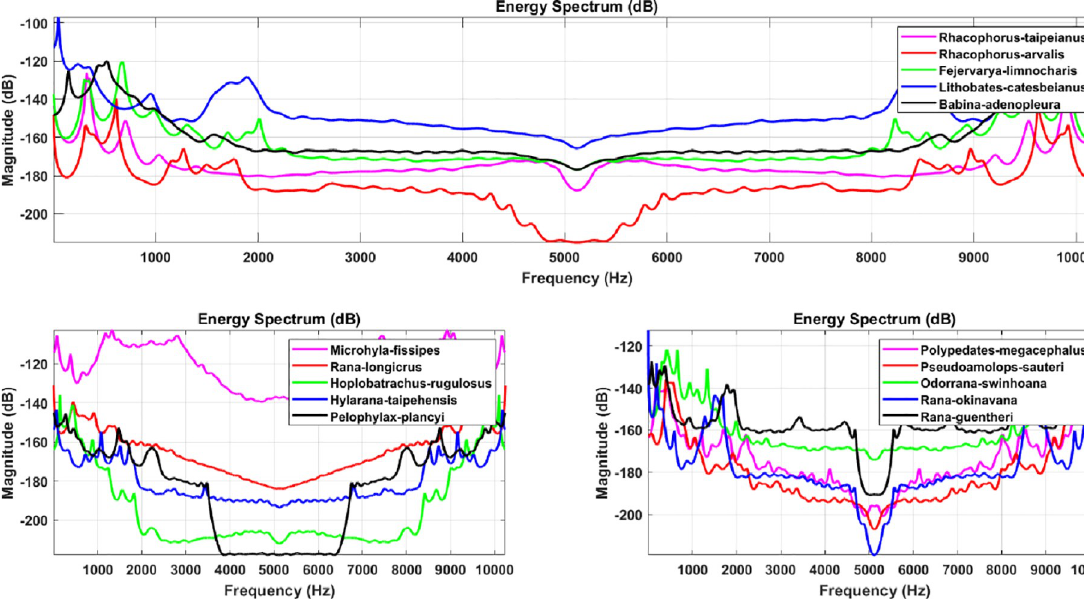
Fig 8. The spectrum diagram of anuran bioacoustic features filtered through the LPC algorithm with P coefficient equal to 60, including Rhacophorus taipeianus , Rhacophorus arvalis , Fejervarya limnocharis , Lithobates catesbeianus , Babina adenopleura , Microhyla ornata , Rana longicrus , Hoplobatrachus rugulosus , Hylarana taipehensis , Pelophylax plancyi , Polypedates megacephalus , Pseudoamolops sauteri , Odorrana swinhoana , Rana okinavana and Rana guentheri .